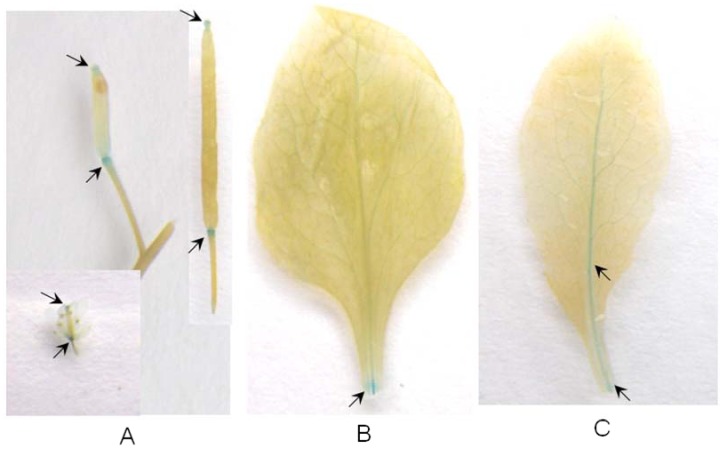
GUS staining of the pBI-P transgenic plants.(A) Strong GUS expression of the AT1G17150 promoter is observed in floral organs including stigma and receptacle. Moreover, this model of expression can continue during silique development period. (B) Wound can induce the activity of the AT1G17150 promoter. (C) Wound signal can be transported over time to other areas via vein (12h after wound).